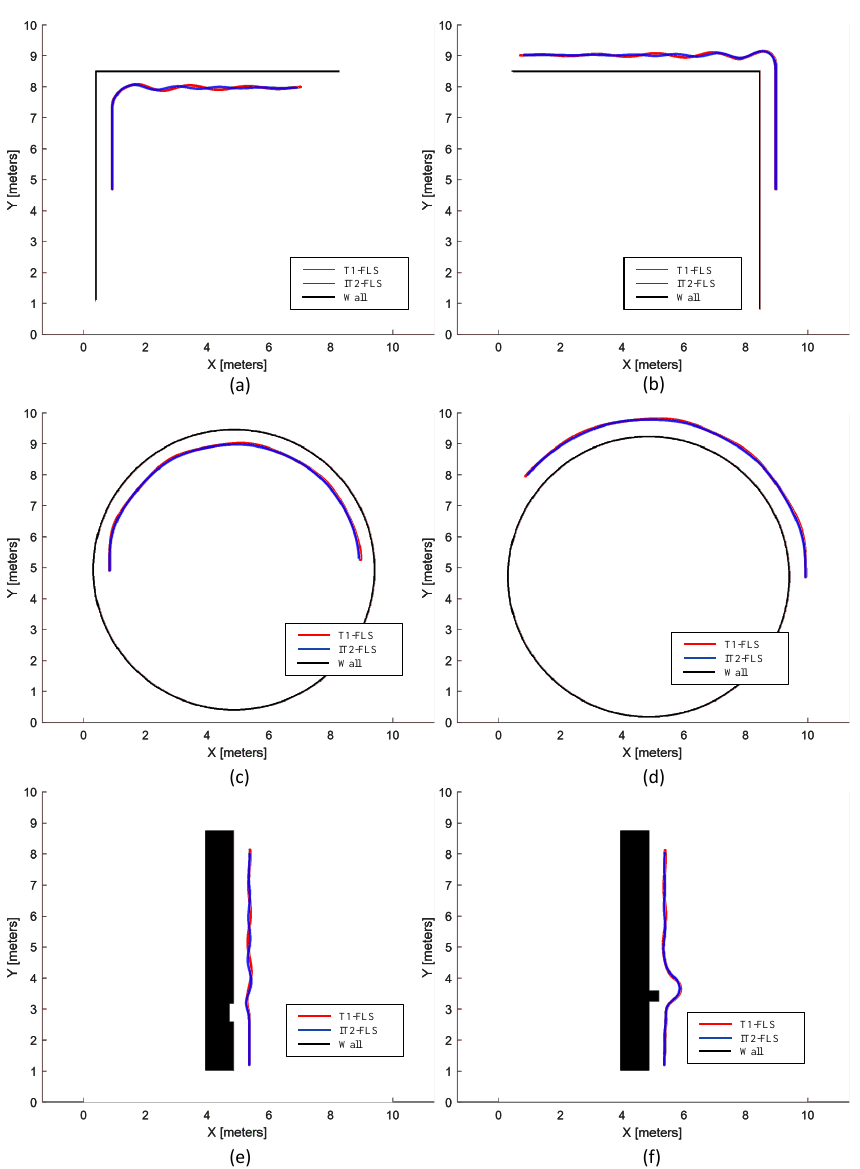
Figure 8. Wall-following behavior of the robot with the T1-FLS and the IT2-FLS during the test cases. ( a ) An inner wall segment of a right-angle corner. ( b ) An outer wall segment of a right-angle corner. ( c ) An inner surface of a curved wall. ( d ) An outer surface of a curved wall. ( e ) A wall segment with a small negative dent. ( f ) A wall segment with a small positive